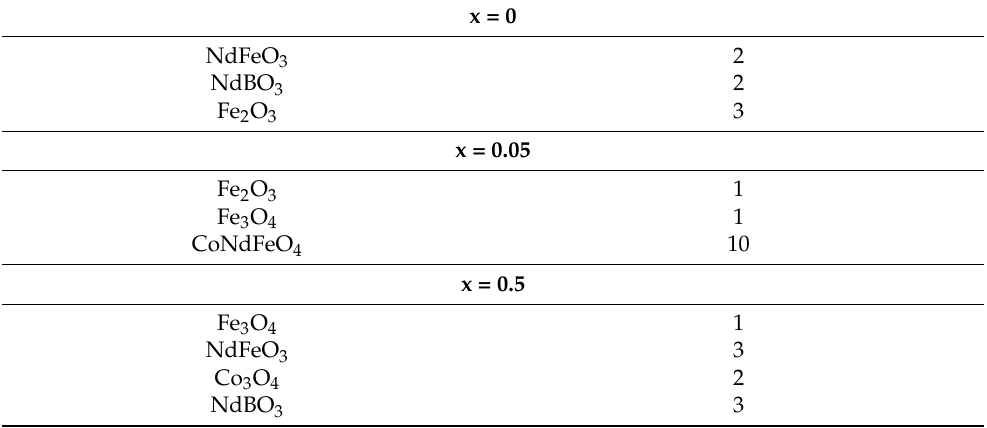
Table 4. Approximate relative concentrations of the NdFe (1 − x) Co x B oxide compounds on the basis of analysis of atomic concentrations from X-ray photoelectron spectra. The given concentrations are used to construct the model